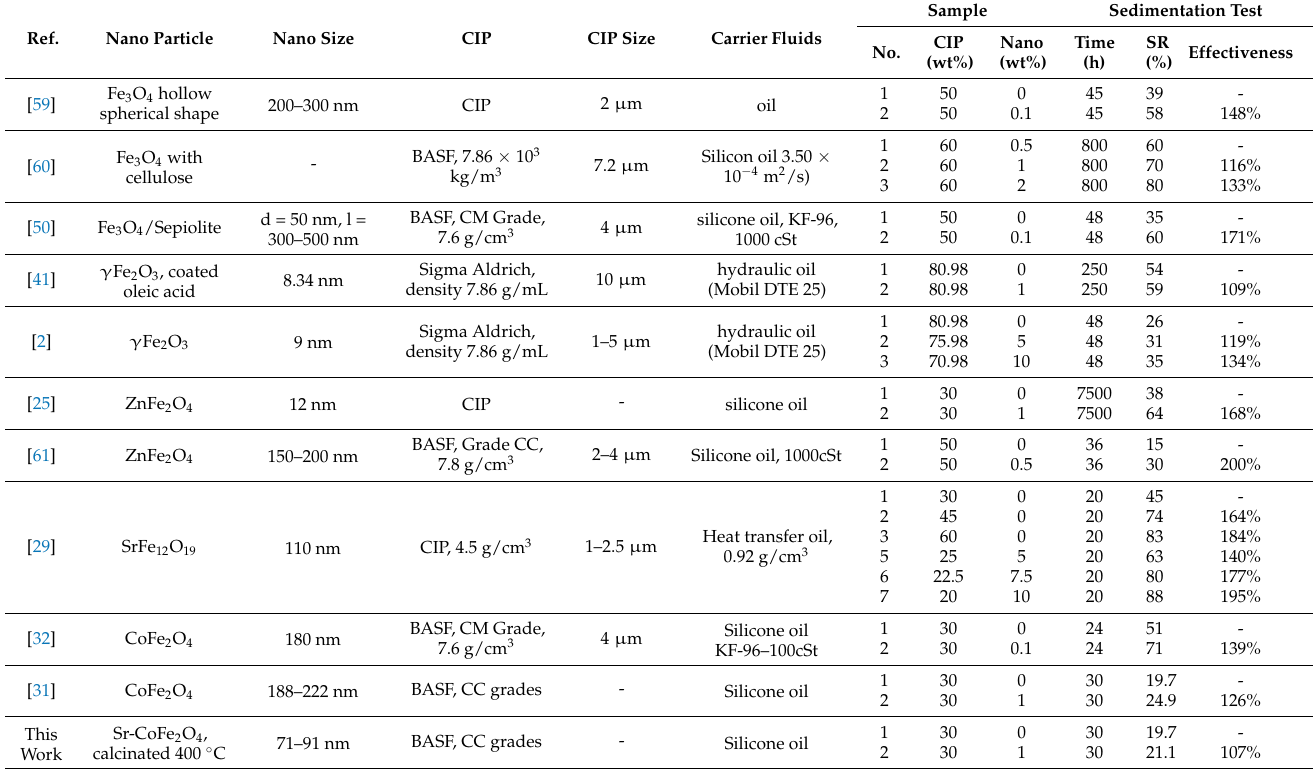
Table 5. Previous research on the stability of dispersions and nano-additives in MRF.